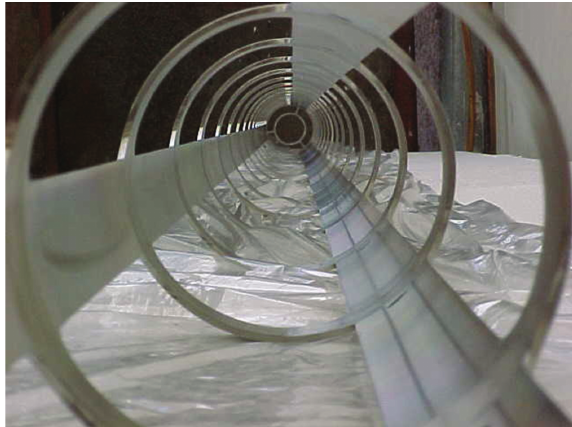
Figure 9: Inner view of an external assembling tube for using in Atucha I.